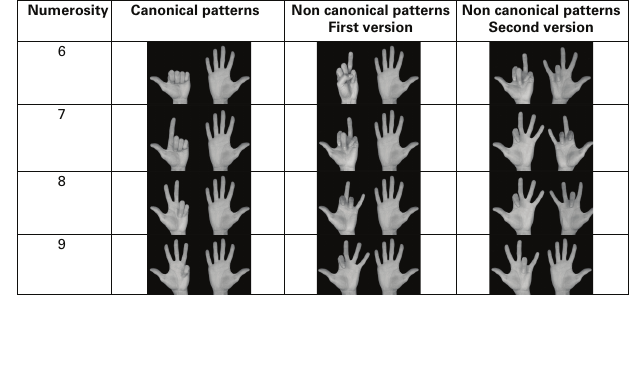
Table A2 | Additional pictures presented in the identification of finger numerical pattern task (adapted from Noël, 2005 and Gracia-Bafalluy and Noël,